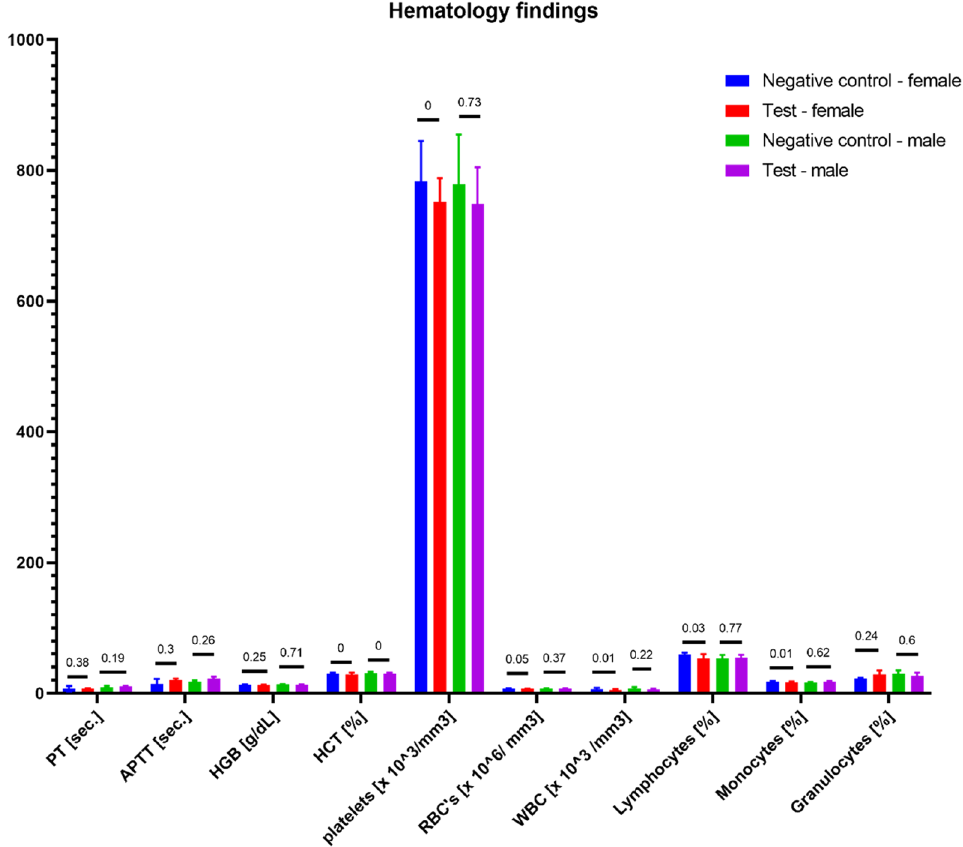
Figure 9. Hematology findings. Statistically significant differences were observed in HCT, WBC, lymphocytes, and monocytes between the control and test group of female rats as well as HCT in male rats. However, the difference did not impact the clinical status of the animals. No other statistically significant differences were observed among the remaining